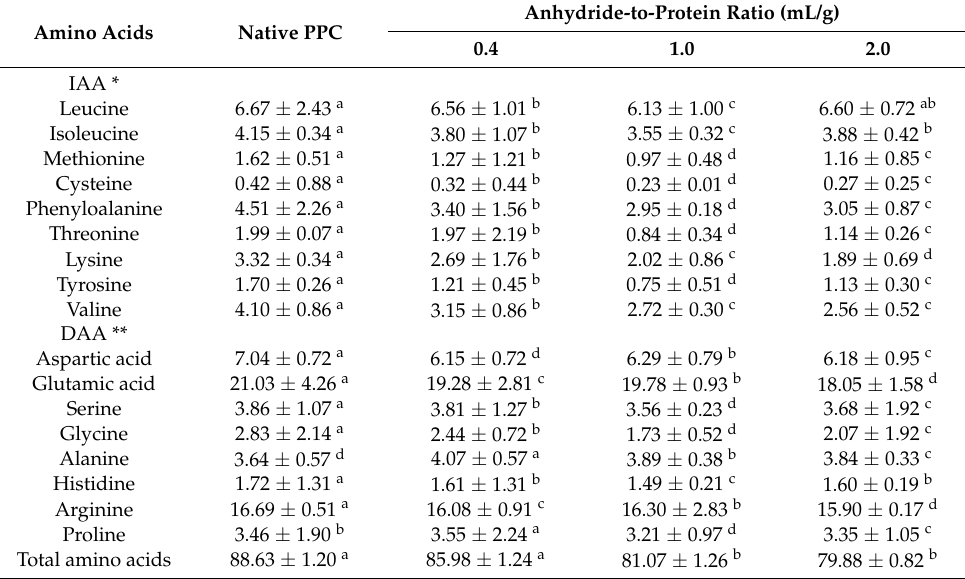
Table 2. Amino acid concentration (g/100 g protein) in native and acetylated PPC. Amino Acids Native PPC